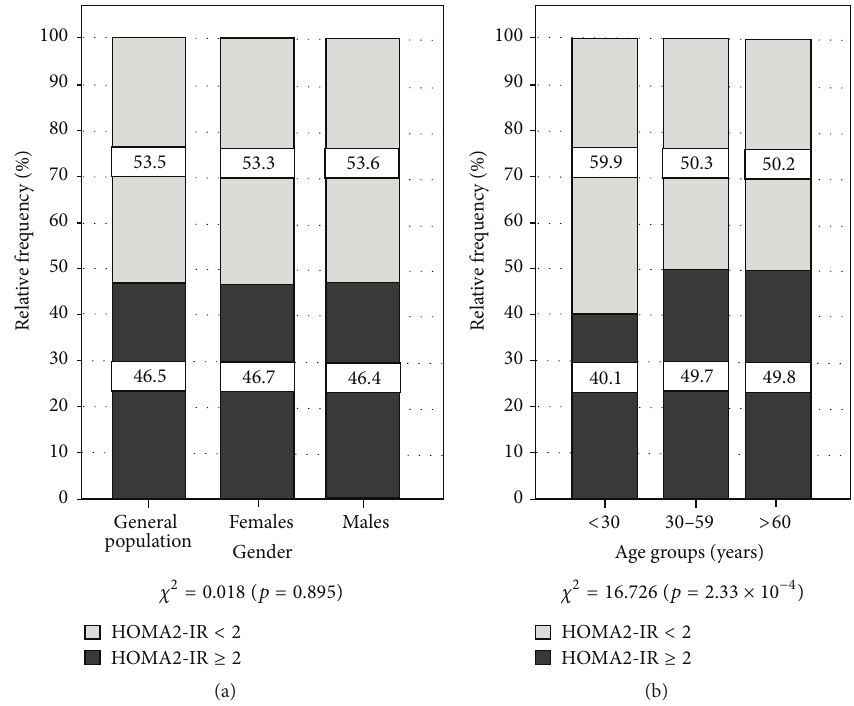
Figure 1: Prevalence of insulin resistance by gender and age groups. Maracaibo, Venezuela. 2014. 𝑍 Test for proportions: gender: nonsignificant. Age groups: < 30 years (HOMA2-IR < 2 versus HOMA2-IR ≥ 2; 𝑝 < 0.05 ); 30–59 years (HOMA2-IR ≥ 2 versus HOMA2-IR < 2; 𝑝 < 0.05 ).